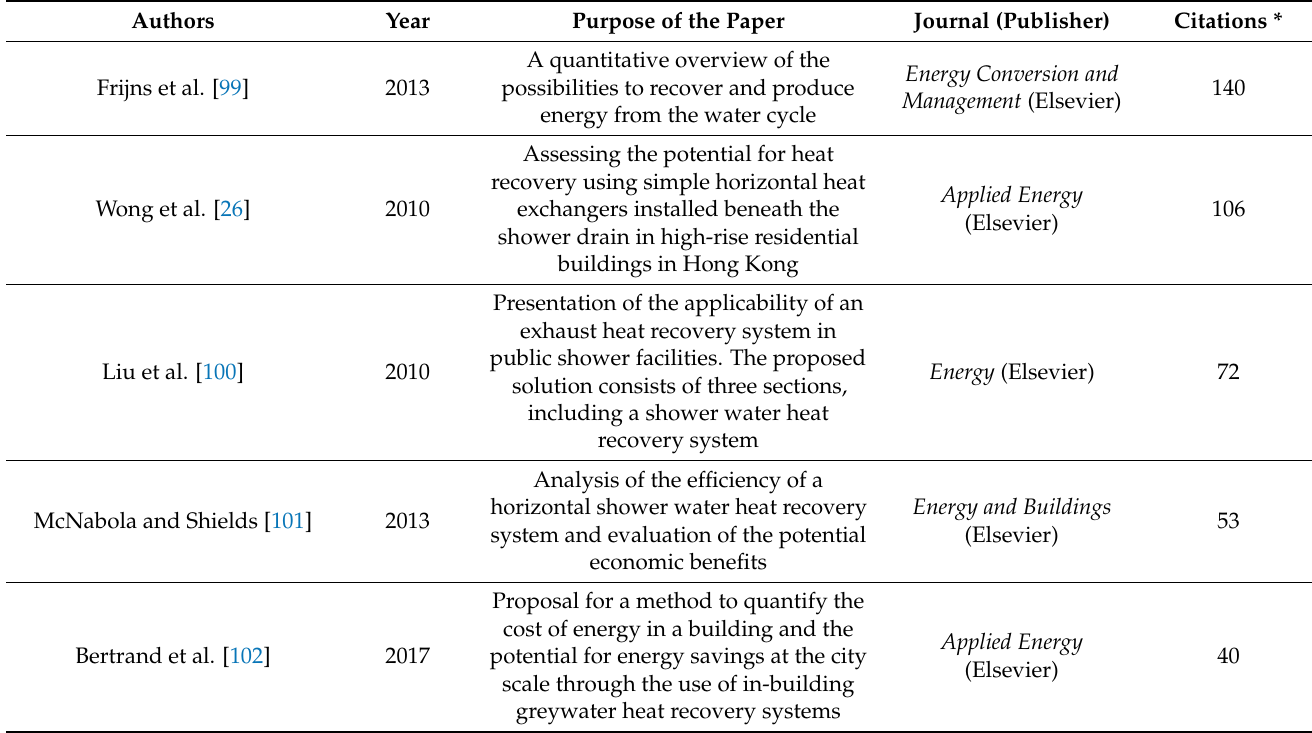
Table 7. The most cited research papers on greywater energy